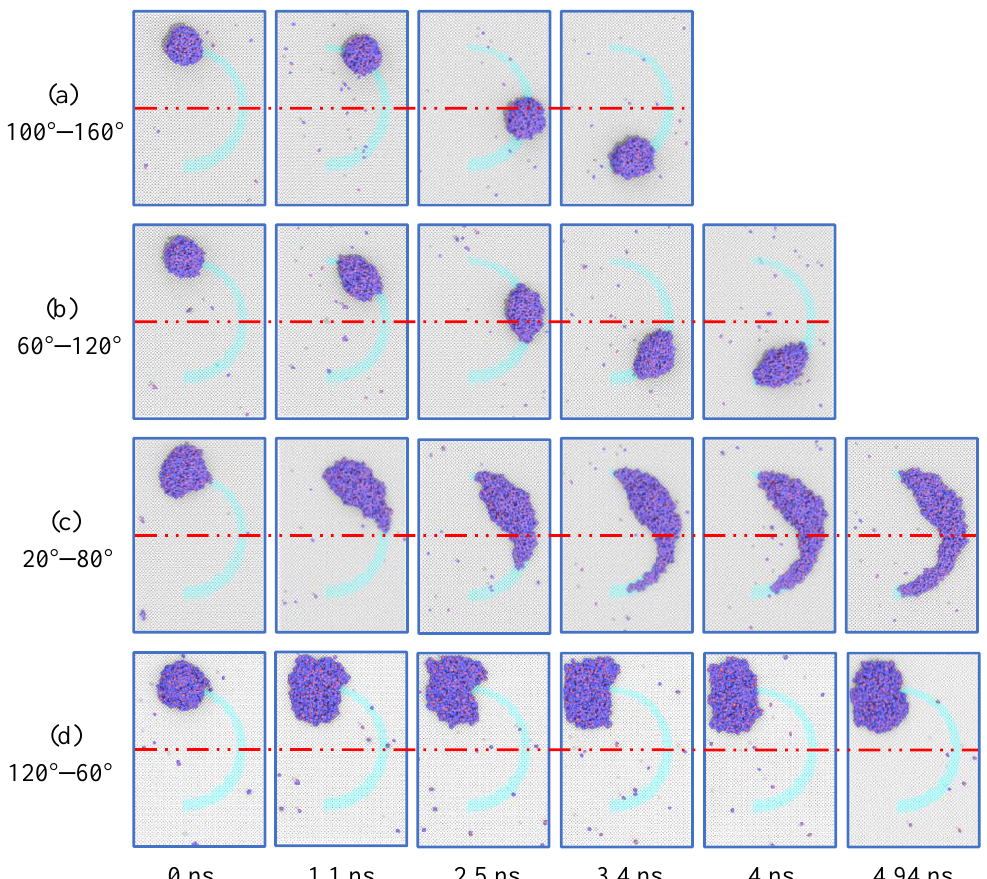
Figure 5. Instantaneous pictures for droplet motion on the curved track. ( a ) hydrophilic surface (CAs θ in the track and background separately being 100 ◦ and 160 ◦ ); ( b ) hydrophilic–hydrophobic surface (CAs θ in the track and background separately being 60 ◦ and 120 ◦ ); and ( c ) hydrophobic surface (CAs θ in the track and background separately being 20 ◦ and 80 ◦ ); ( d ) hydrophobic–hydrophilic surface (CAs θ in the track and background separately being 120 ◦ and 60 ◦ ). Red center line is marked to assist in observing droplet movement.